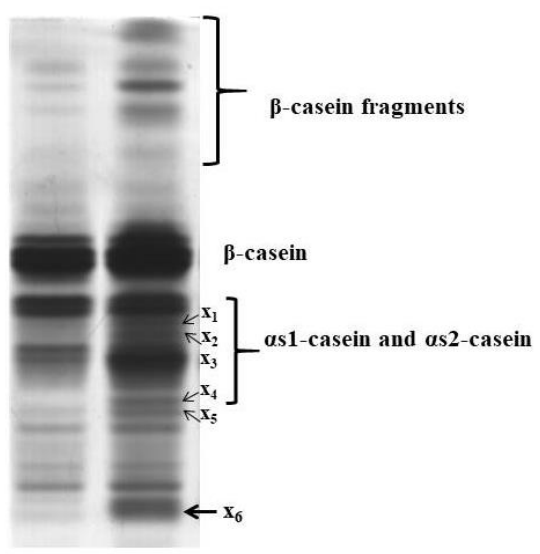
Figure 3. Urea polyacrylamide gel electrophoresis (urea-PAGE) patterns of donkey milk (left slot) and cheese after moulding (right slot).